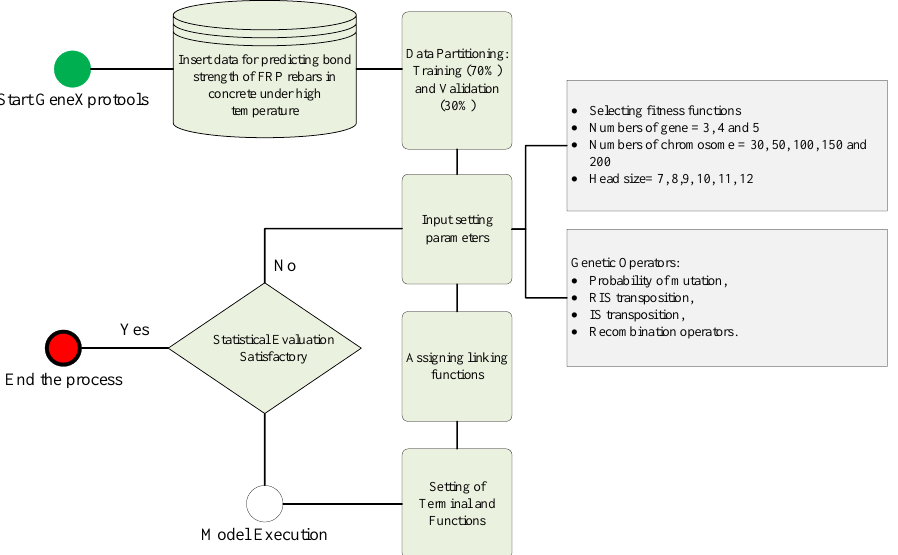
Figure 2. GEP framework for predicting the FRP bond strength.